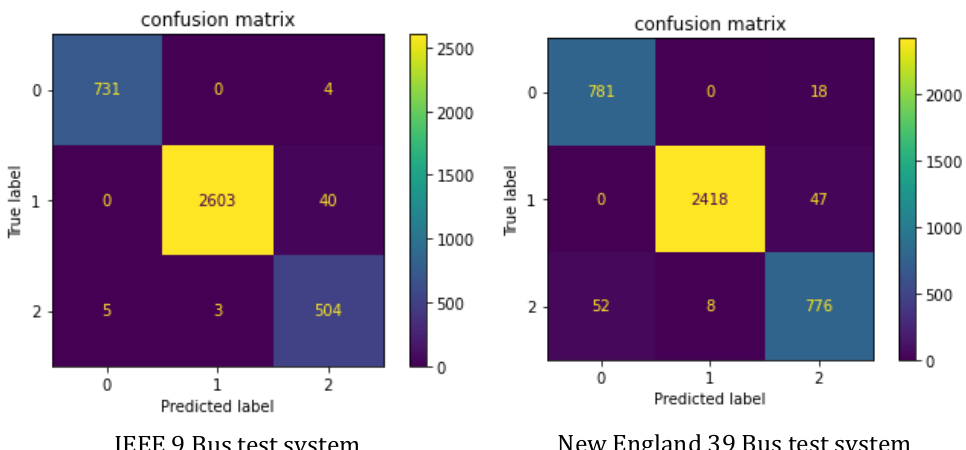
Figure 12. Confusion matrix of test results for the proposed model on test systems. Table 5. Comparison of performance of proposed model with other deep learning and machine learning